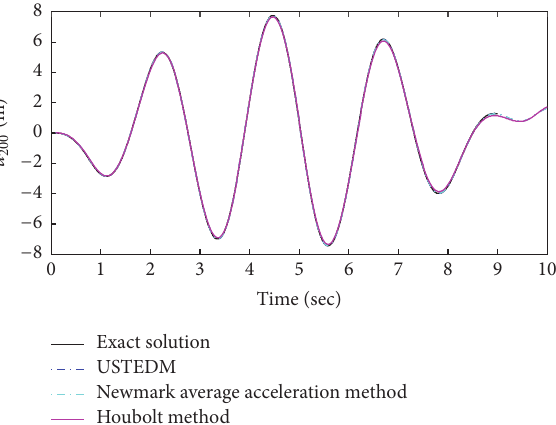
Figure 6: Displacement responses of 200th DOF system.